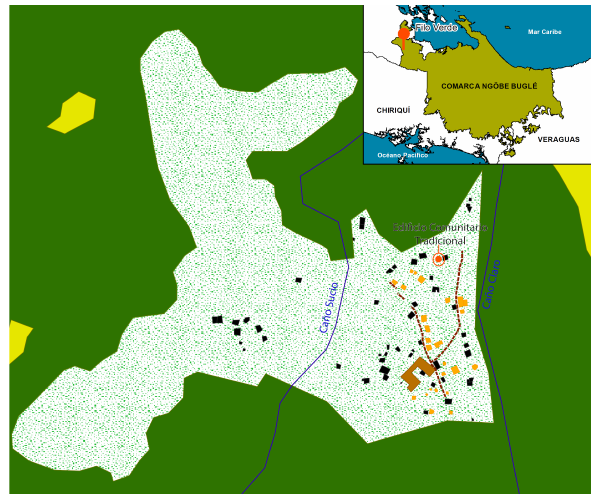
Figure 2. Map of Filo Verde, Ngäbe area (I.